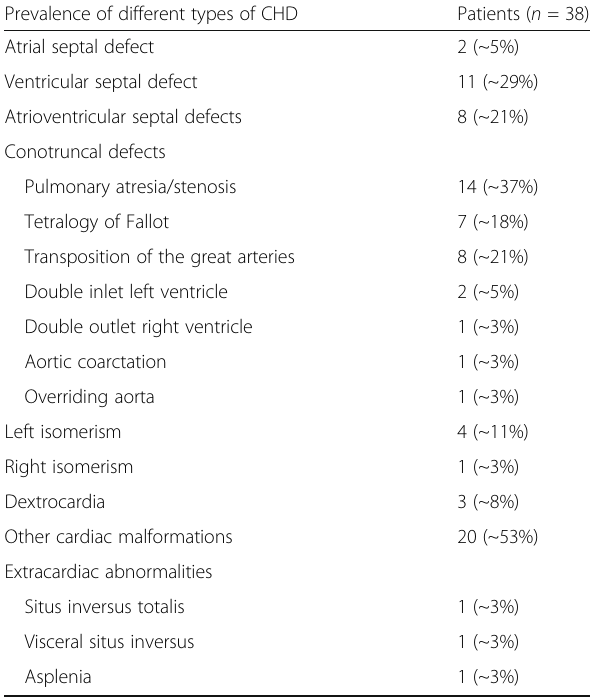
Table 1 Clinical characteristics of the patients genotyped Prevalence of different types of CHD Patients ( n =